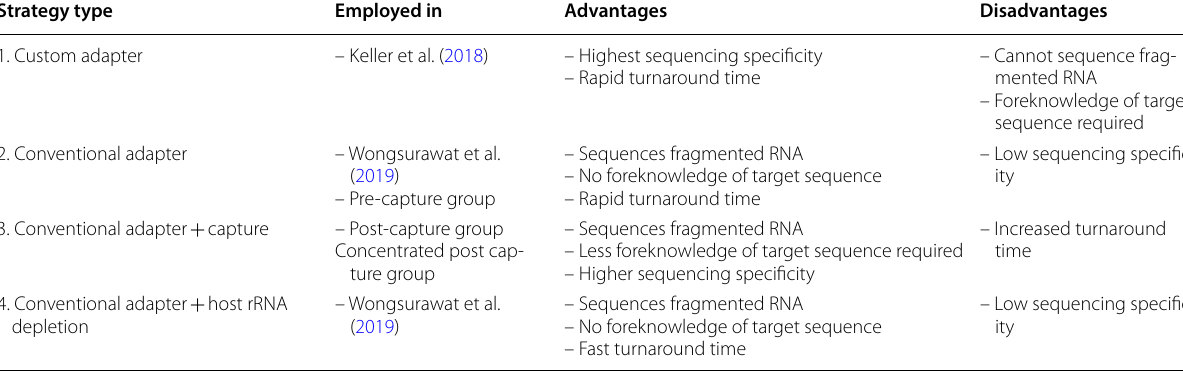
Table 3 Summary of advantages and disadvantages of strategies for direct RNA sequencing of RNA viruses Strategy